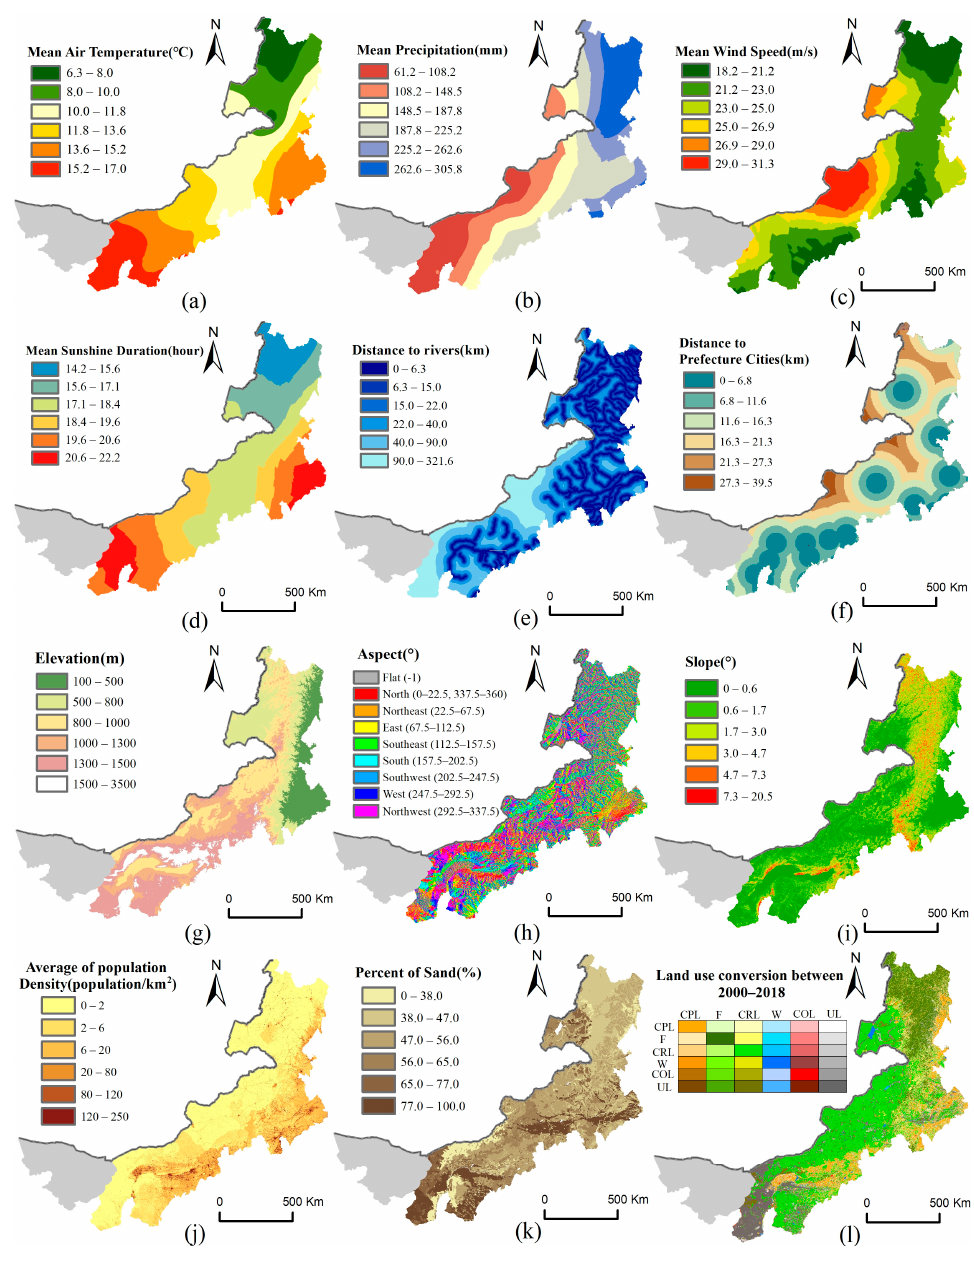
Figure 2. Factor grading (MAT( a ), MP ( b ), MWS ( c ), MSD ( d ), DTR ( e ), DTC ( f ), Elevation ( g ), Aspect ( h ), Slope ( i ), AOPD ( j ), POS ( k ), LUCC ( l ) (CPL: CropLand; F: Frost; CRL: Crass Land; W: Water Area; COL: Construction Land; UL: Unused Land)).